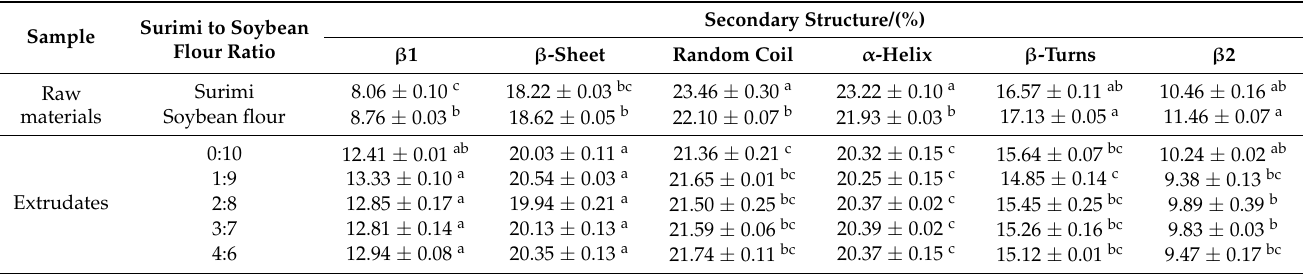
Table 3. The relative percentage of protein secondary structure for raw materials and extrudates with different surimi to soybean flour